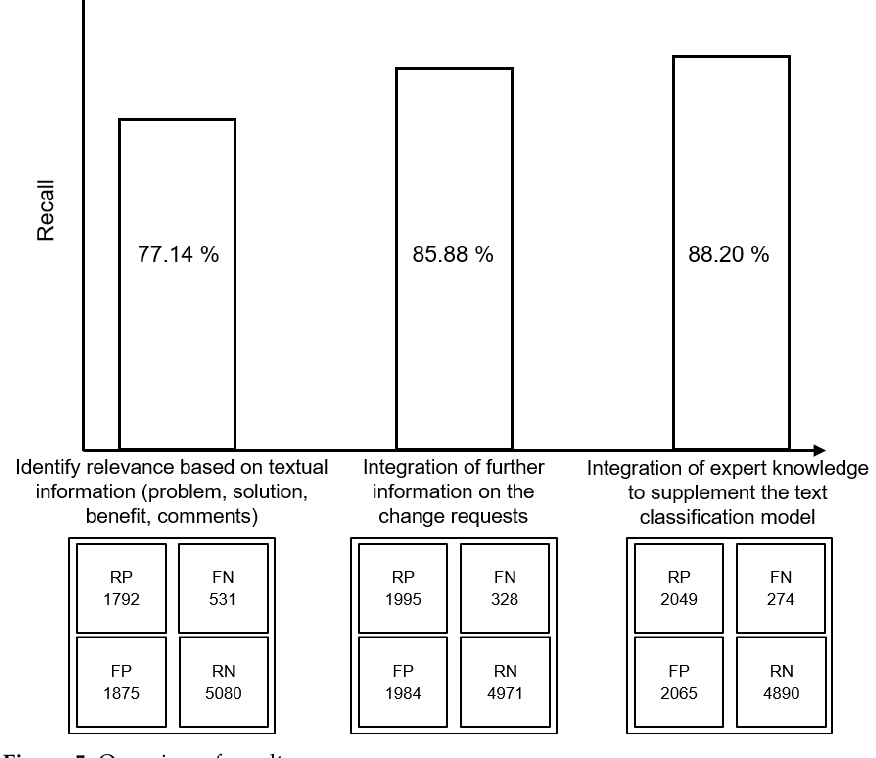
Figure 5. Overview of